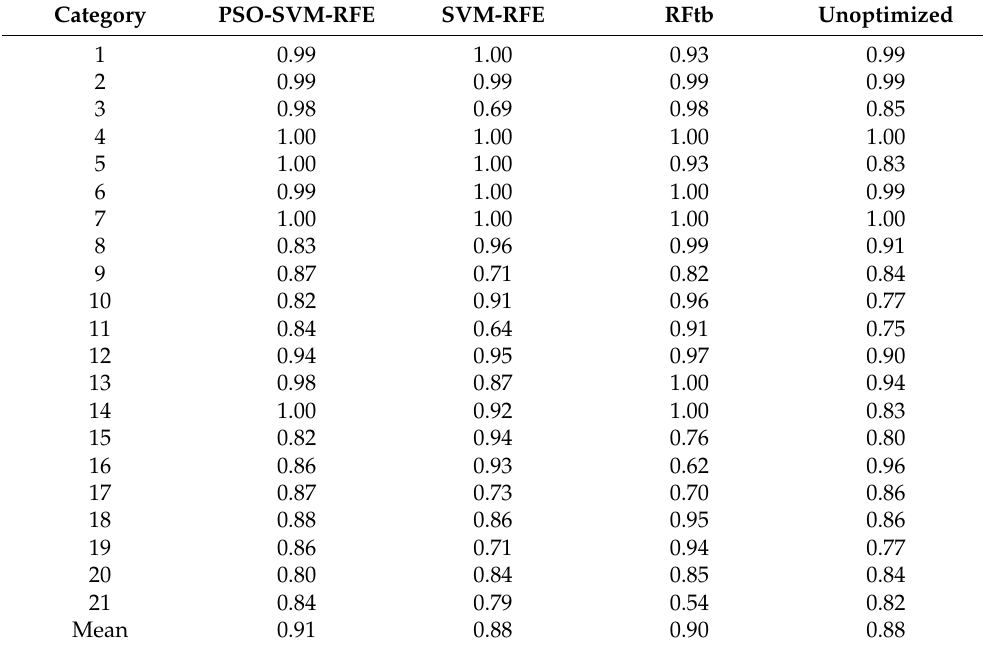
Table 6. The fault diagnosis rates of various feature selection models.